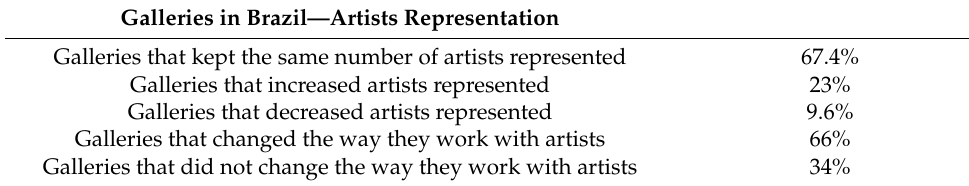
Table 3. Artists’ representation in Brazilian